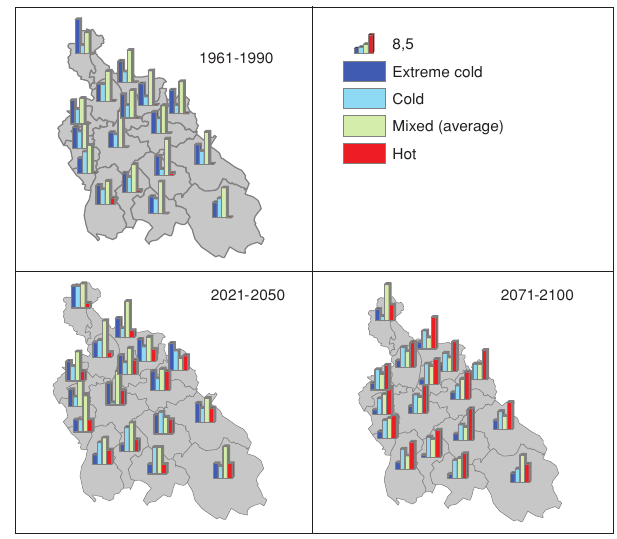
Figure 5. Changes of climatic year types regarding